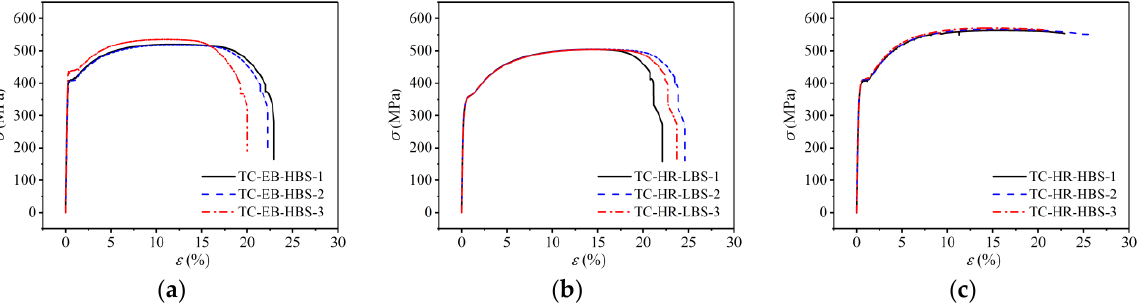
Figure 6. Stress-strain curves of specimens: ( a ) TC-EB-HBS-1, 2 and 3; ( b ) TC-HR-LBS-1, 2 and 3; and ( c ) TC-HR-HBS-1, 2 and 3.